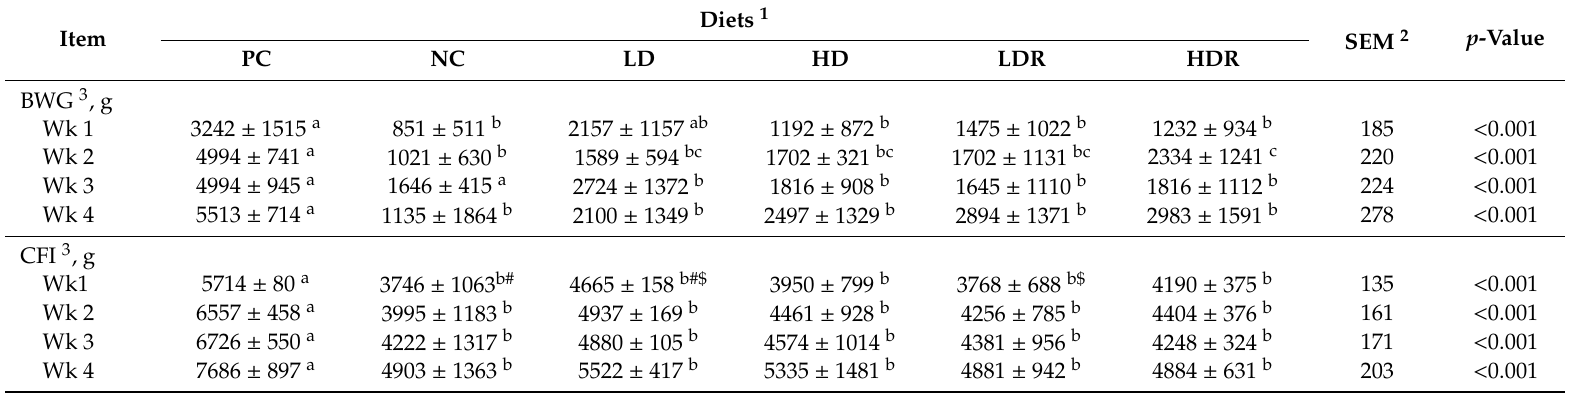
Table 3. Weekly growth performance of pigs fed with low-protein diets supplemented with a corn-expressed